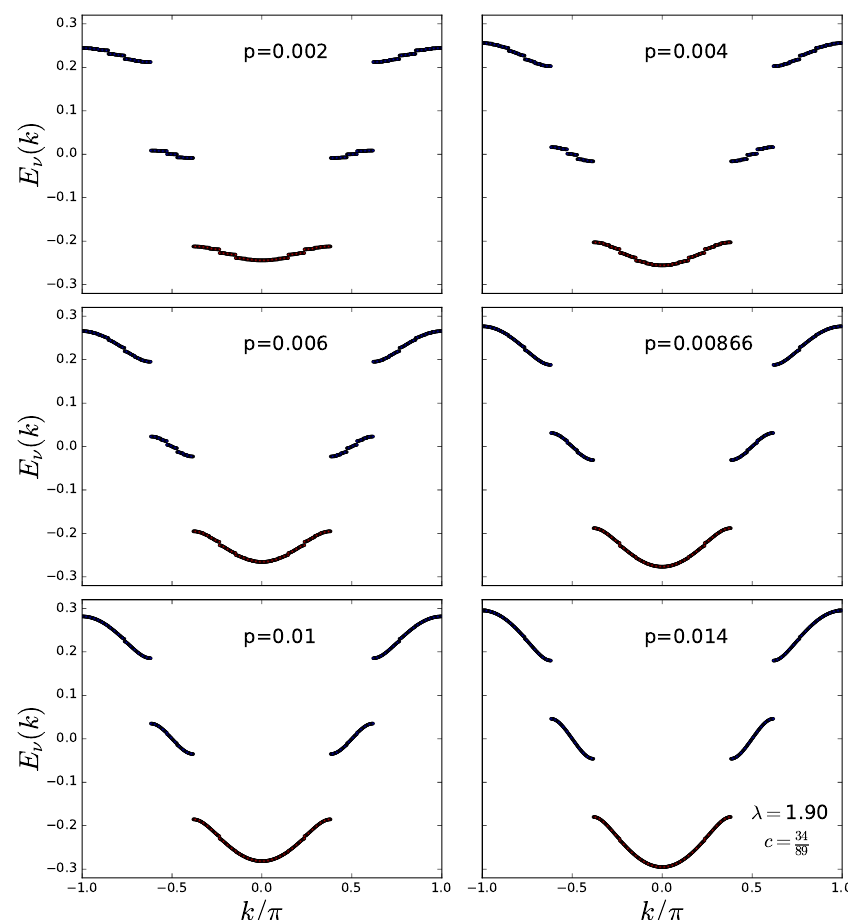
Figure 18: Energy bands in the unfolded Brillouin zone for the c = 34 of the incommensurate case, for different pressures p showing gap openings at low pressures. λ = 1.90, ξ =